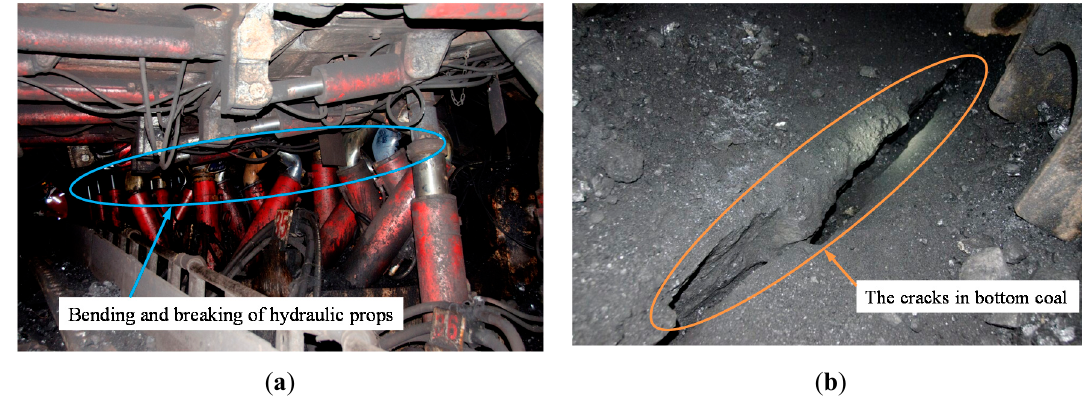
Figure 2. Generalized stratigraphic column of the geological borehole.